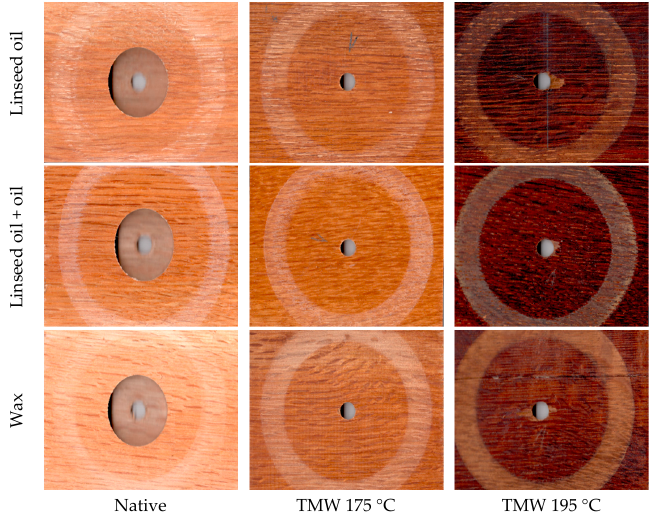
Figure 6. Grinded surface finishes after resistance to abrasion testing (after 100